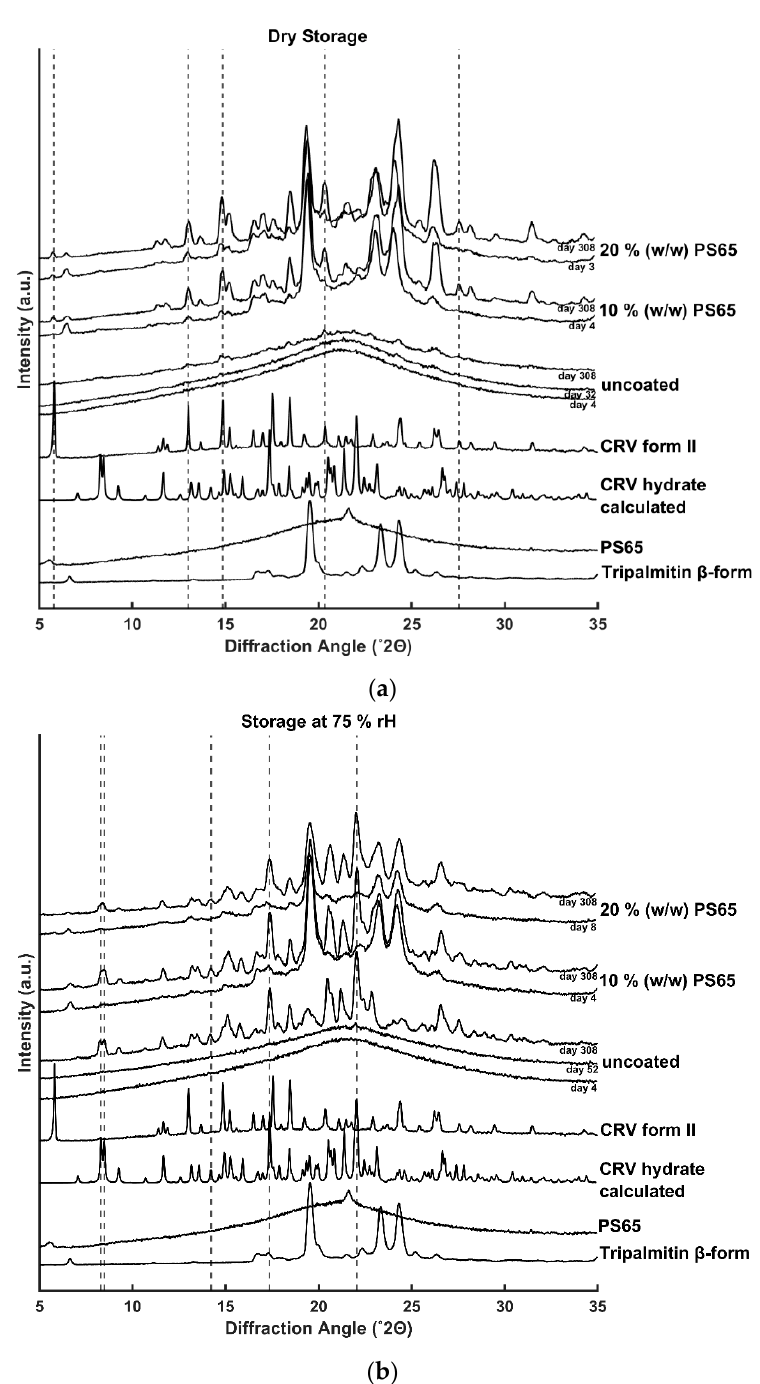
Figure 2. XRPD diffractograms of uncoated and coated amorphous CRV particles (10% ( w/w ) PS65) and (20% ( w/w ) PS65). The samples were stored at ( a ) dry condition and ( b ) 75% rH for more than 10 months. Characteristic diffractions of the polymorphic form II and the hydrate form of CRV are highlighted by the dashed vertical lines and serve as a guide for the eye.